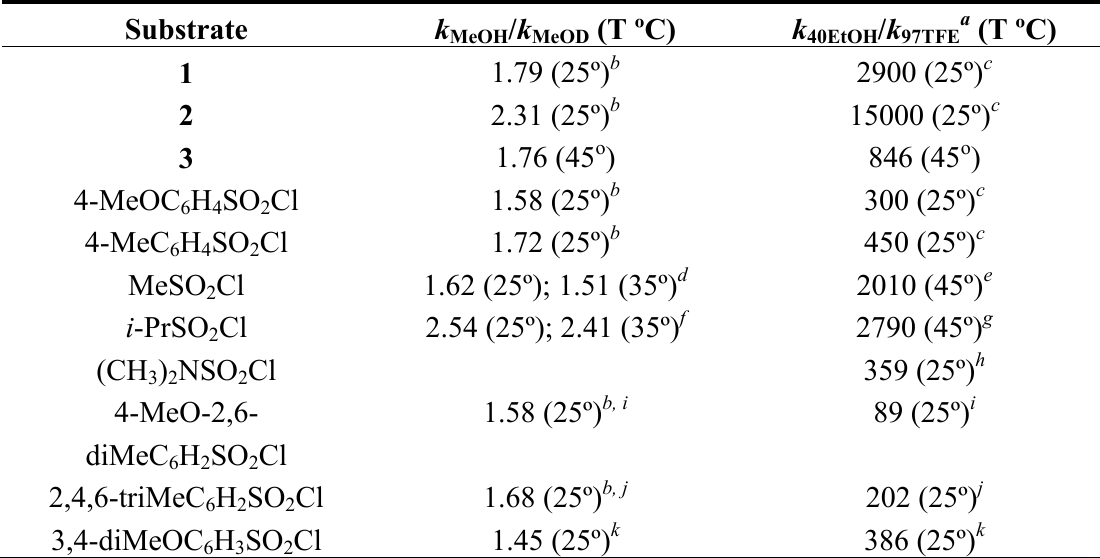
methanol- d ( k / k ) and the ratios of specific rates for solvolyses in 40% (v/v) MeOH MeOD ethanol-water relative to 97% (w/w)